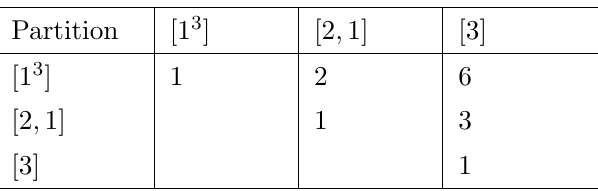
Table 3 . Ratios of Coulomb branch volumes for k = 3, n = 3